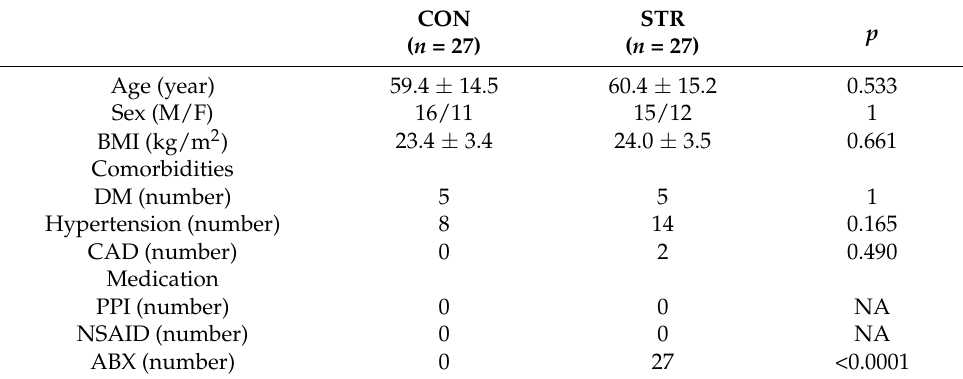
Abbreviations: CON, healthy controls; STR, stroke patients; BMI, body mass index; DM, diabetes mellitus; CAD, coronary heart disease; PPI, proton pump inhibitor; NSAID, non-steroidal anti-inflammatory drug;